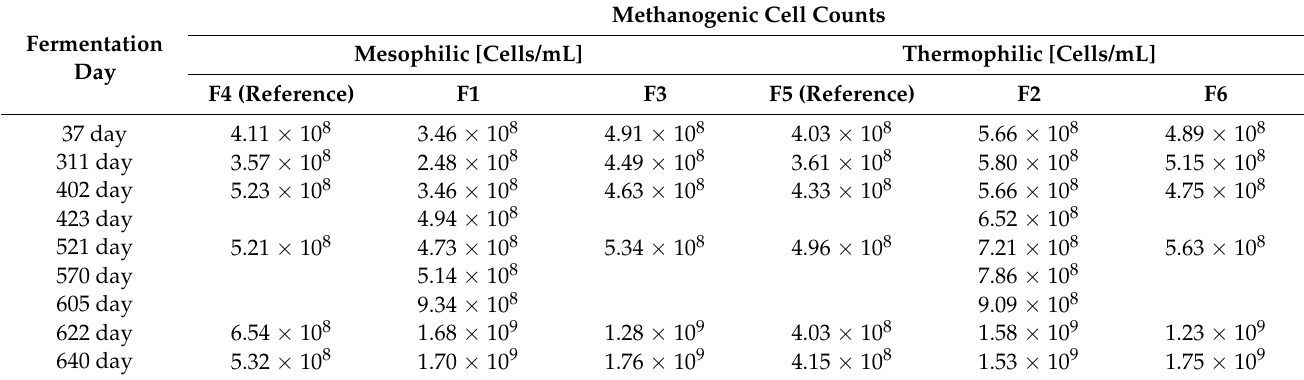
Table 4. Semi-automated cell counts by quantitative microscopy, during long-term anaerobic diges- tion of wheat straw, with ‘synthetic manure’ in the six fully automated and continuously stirred fermenters F1–F6. Data for only auto-fluorescent methanogenic cells.